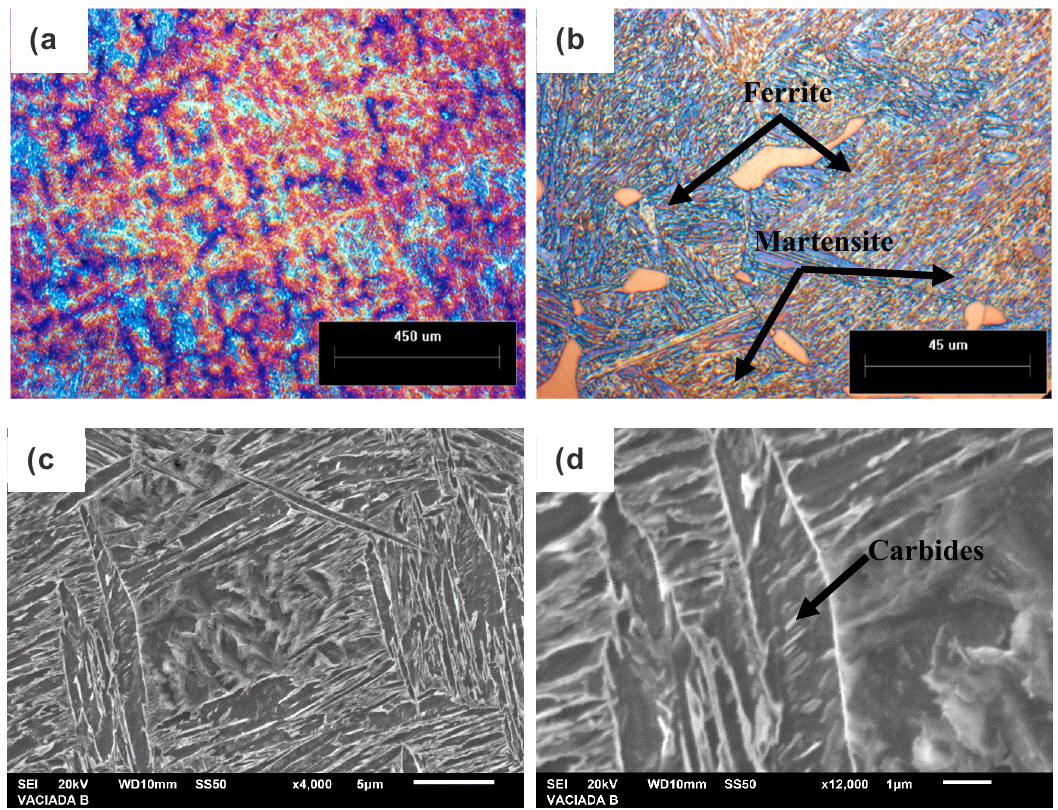
Figure 5. ( a , b ) Optical and ( c , d ) scanning electron microscope images showing the microstructure of as-cast condition.